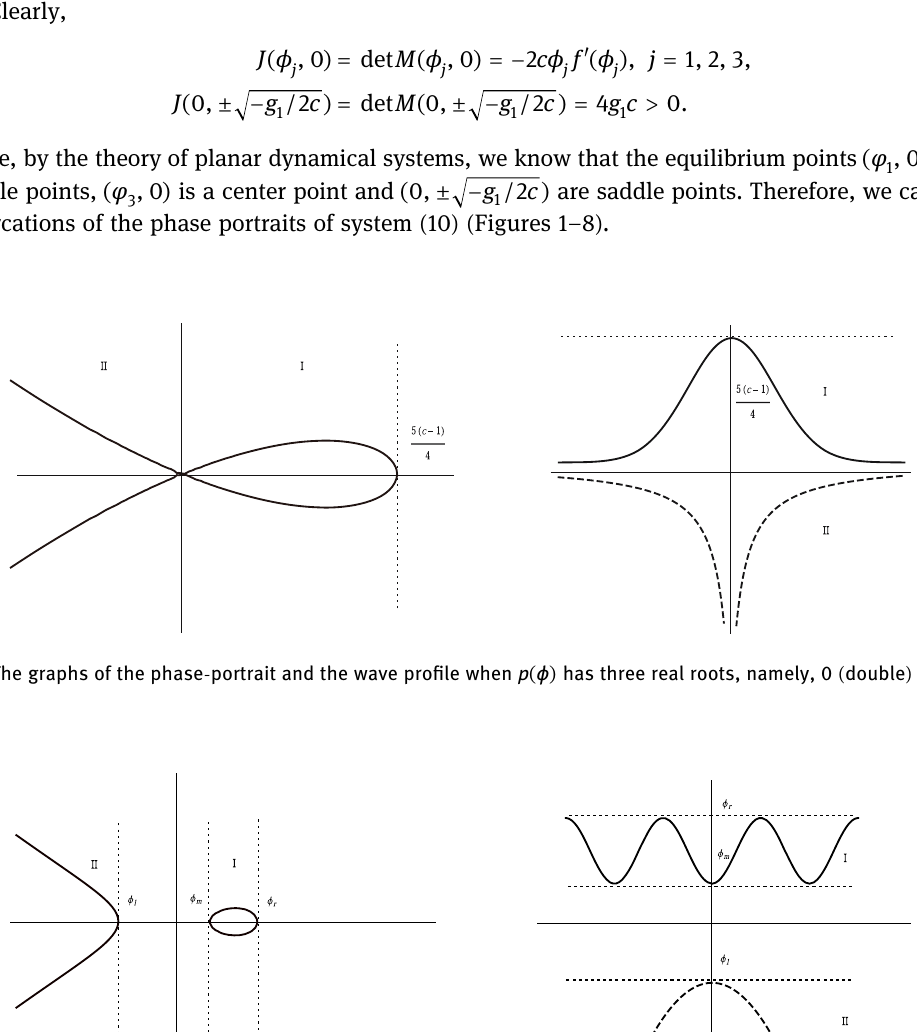
Figure 2: The graphs of the phase - portrait and the wave pro fi le when ( ) p ϕ has three real roots, namely, ϕ